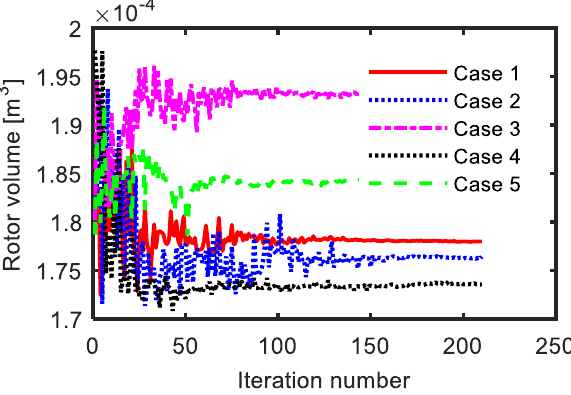
Figure 6. Rotor iron volume versus iteration number for different cases.